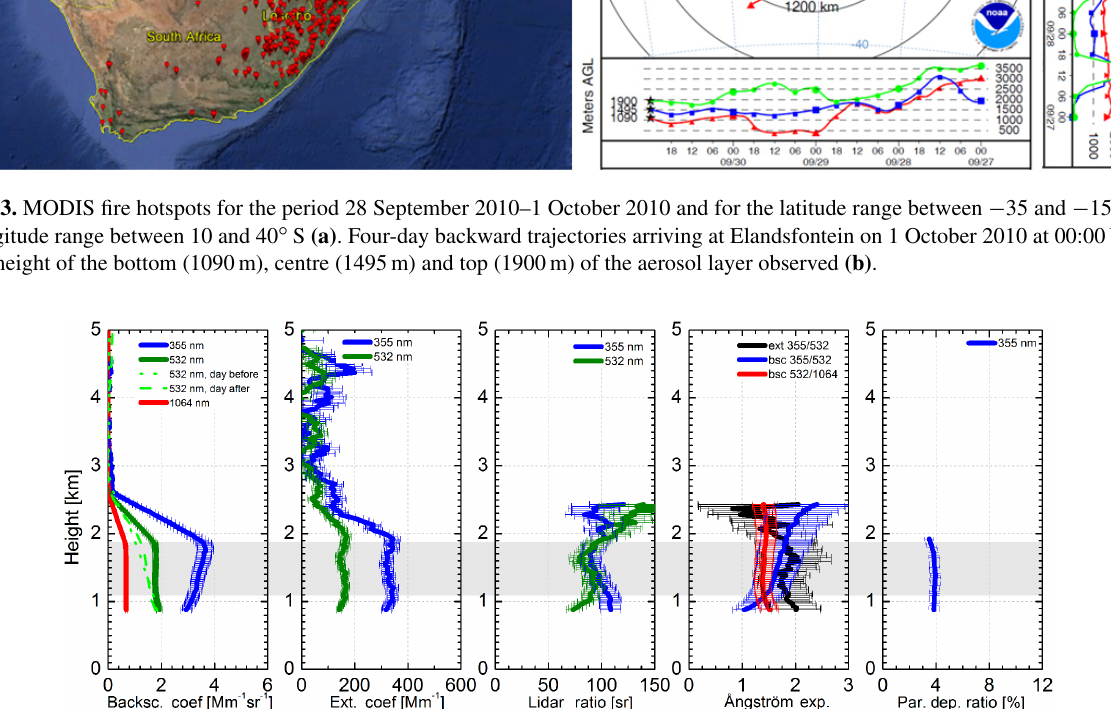
Figure 4. Backscatter coefficients, extinction coefficients, lidar ratios, Ångstrom exponents and particle depolarization ratio at Elandsfontein on 1 October 2010,